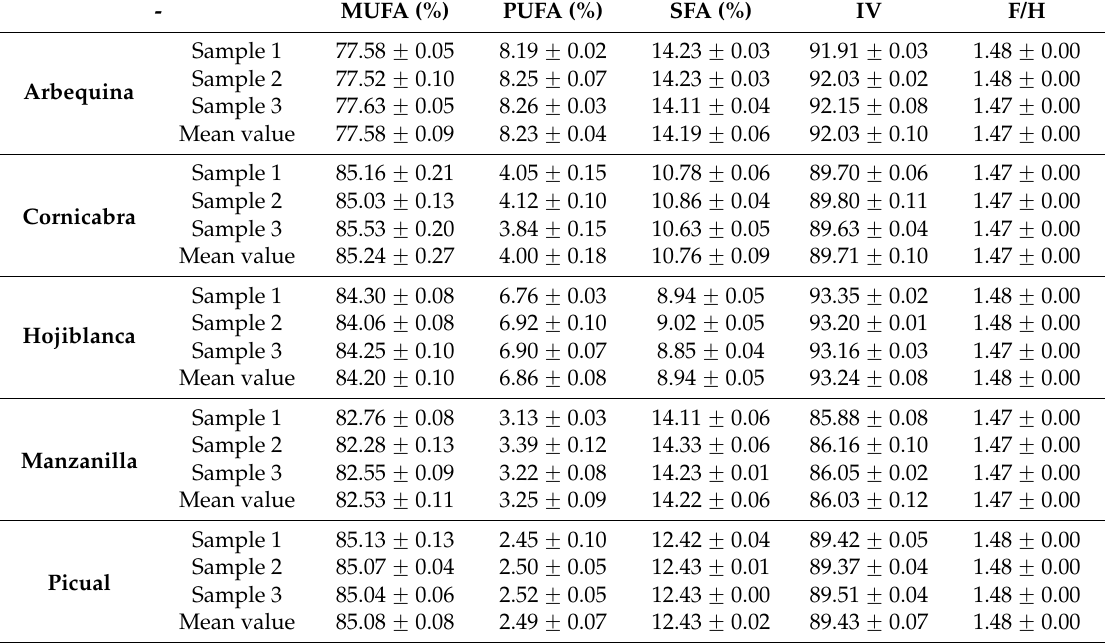
Table 1. Mean values and standard deviations of the fatty acid compositions (%) of the different Spanish extra virgin olive oils